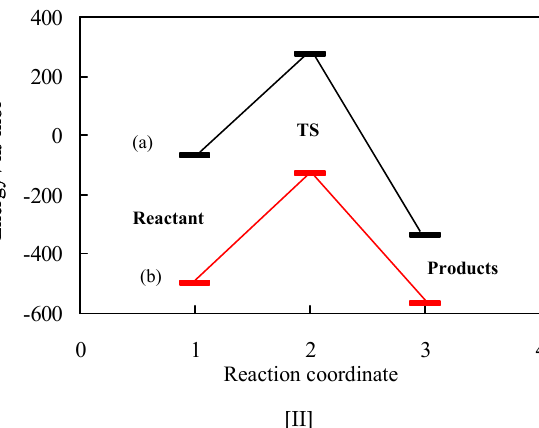
Figure 5. Optimized structures at the reactant, TS and product between benzene, H 2 O and H 2 O 2 system in the absence [ Ia ] and presence [ Ib ] of Pt 3 as co-catalyst for the hydroxylation of benzene to form phenol; and energy potentials for intrinsic reaction coordinates (IRC) [ II ]. The stabilization energy at each state was calculated by the difference from the energy of isolated system. The bond distance ( Å ) of O–H in H 2 O (blue), O–O in H 2 O 2 (green) and C–H in benzene (red) were indicated.